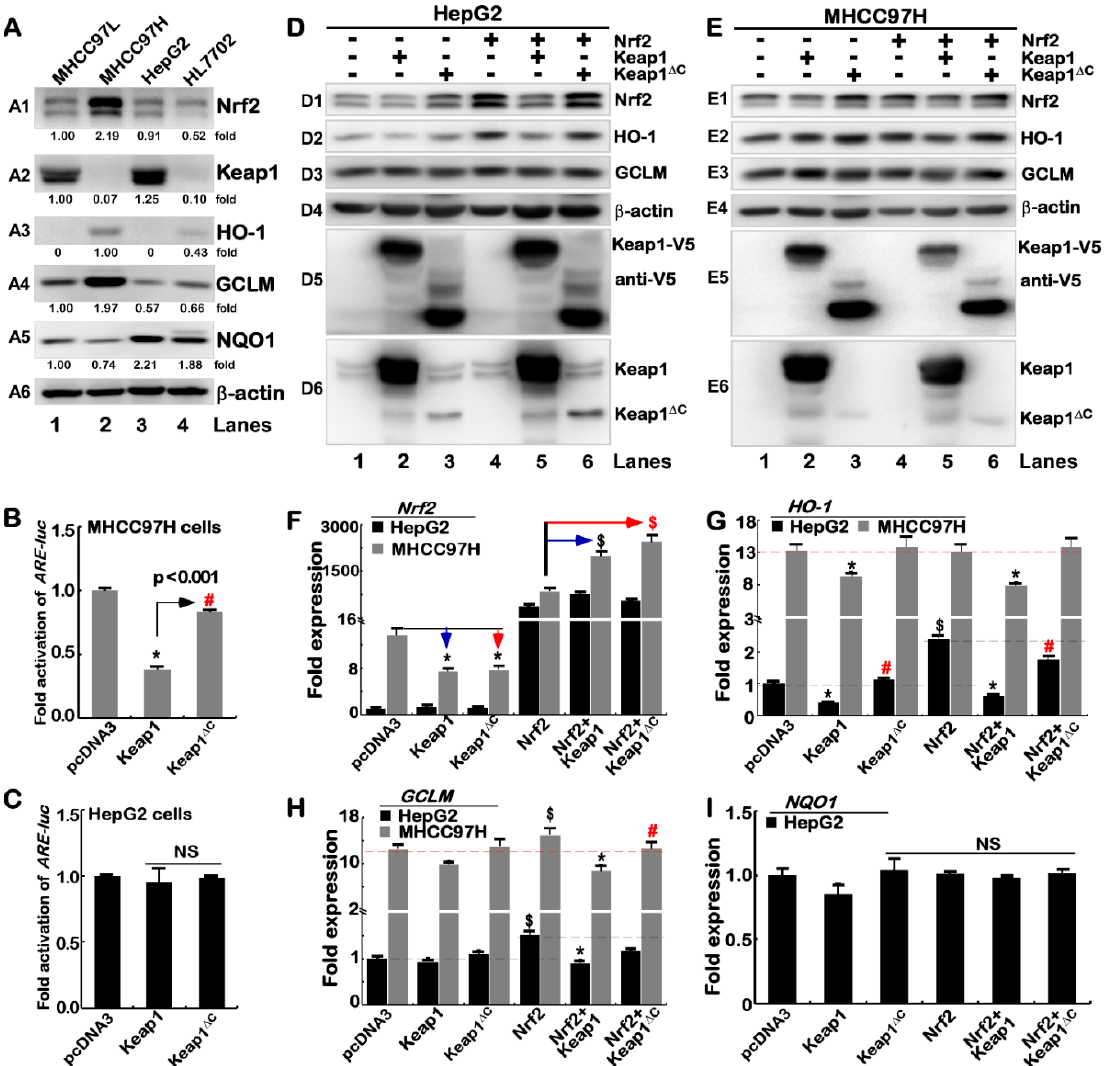
Figure 3. An effect of Keap1 Δ C is distinctive from Keap1 on Nrf2-target genes. ( A ) Different expression levels of endogenous proteins Keap1, Nrf2, HO-1, GCLM and NQO1 were determined by Western blotting of four distinct cell lines as indicated. β -actin served as a loading control. ( B , C ) An ARE -driven fluorescent reporter (pARE-Luc), another internal control pRL-TK, together with an expression construct for Keap1 or Keap1 Δ C , were co-transfected into MHCC97H ( B ) or HepG2 cells ( C ). After 24 h, the luciferase activity was assayed ( # p < 0.01, * p < 0.001, n = 3 × 3; NS = not significant). Both HepG2 ( D )and MHCC97H ( E ) cell lines were or were not co-transfected with expression plasmids for Keap1 or Keap1 Δ C alone or plus Nrf2. After 24 h the total lysates were subjected to Western blotting with distinct antibodies against Nrf2, HO-1, GCLM, β -actin, Keap1 and its V5 tag. ( F – I ) Similarly transfected cells as described above were subjected to real-time qPCR analysis of Nrf2 , HO-1 , GCLM and NQO1 at the mRNA expression levels. The color arrows indicate comparison with the control group, significant increases (# or $ p < 0.01, n = 3 × 3) and/or significant decreases ( * p < 0.01, n = 3 × 3) were determined with error bars (S.E.).